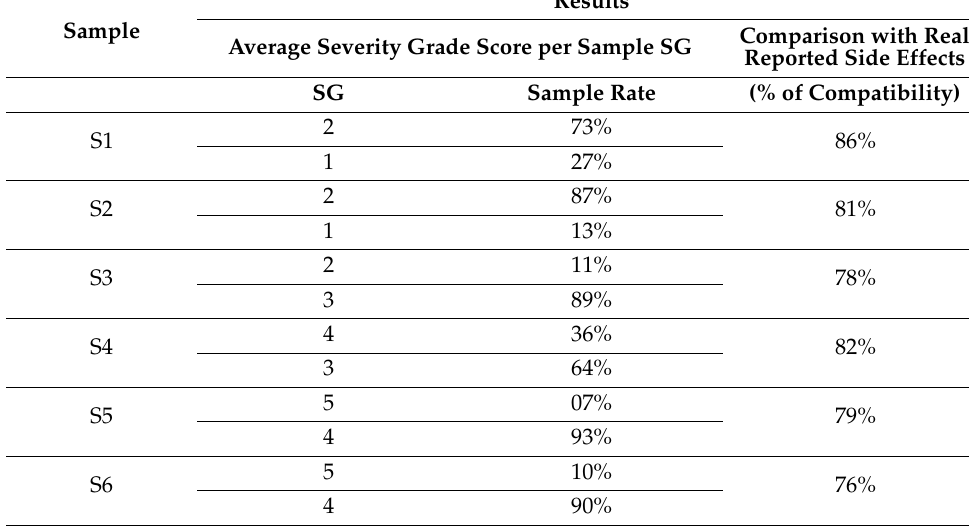
Table 9. Results for average severity grade score per sample SG and a comparison with real reported side